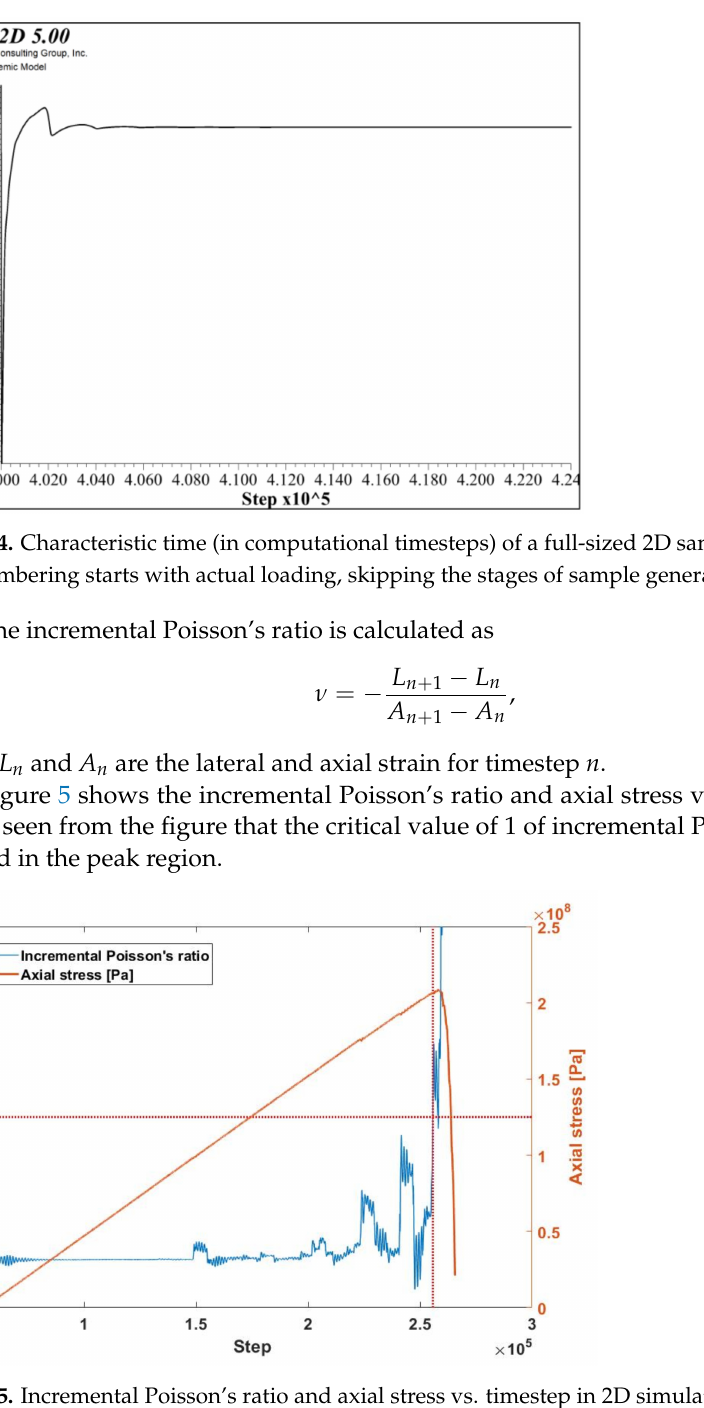
Figure 5. Incremental Poisson’s ratio and axial stress vs. timestep in 2D